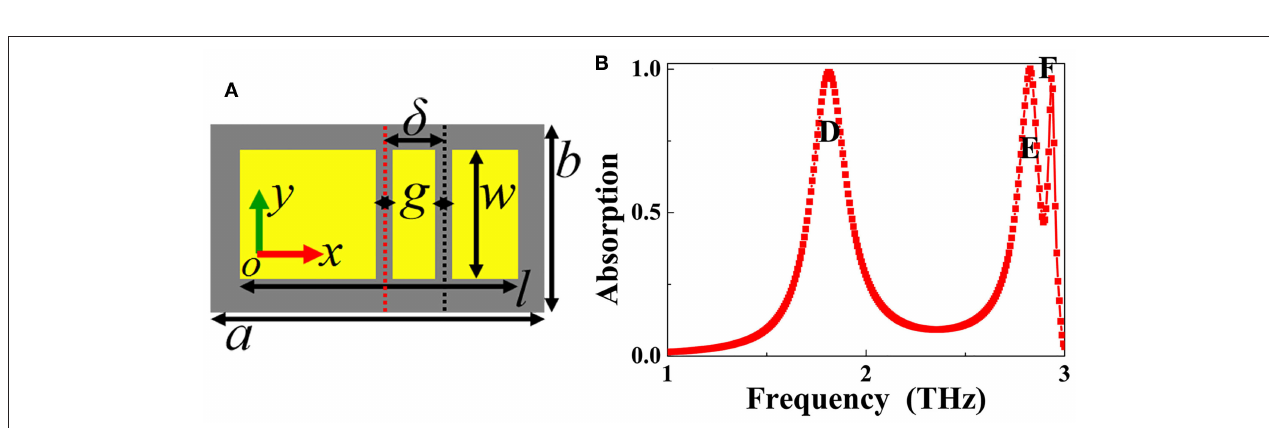
FIGURE 6 | (A) Top view of triple-band metamaterial absorber; (B) Absorption response of the triple-band metamaterial absorber.